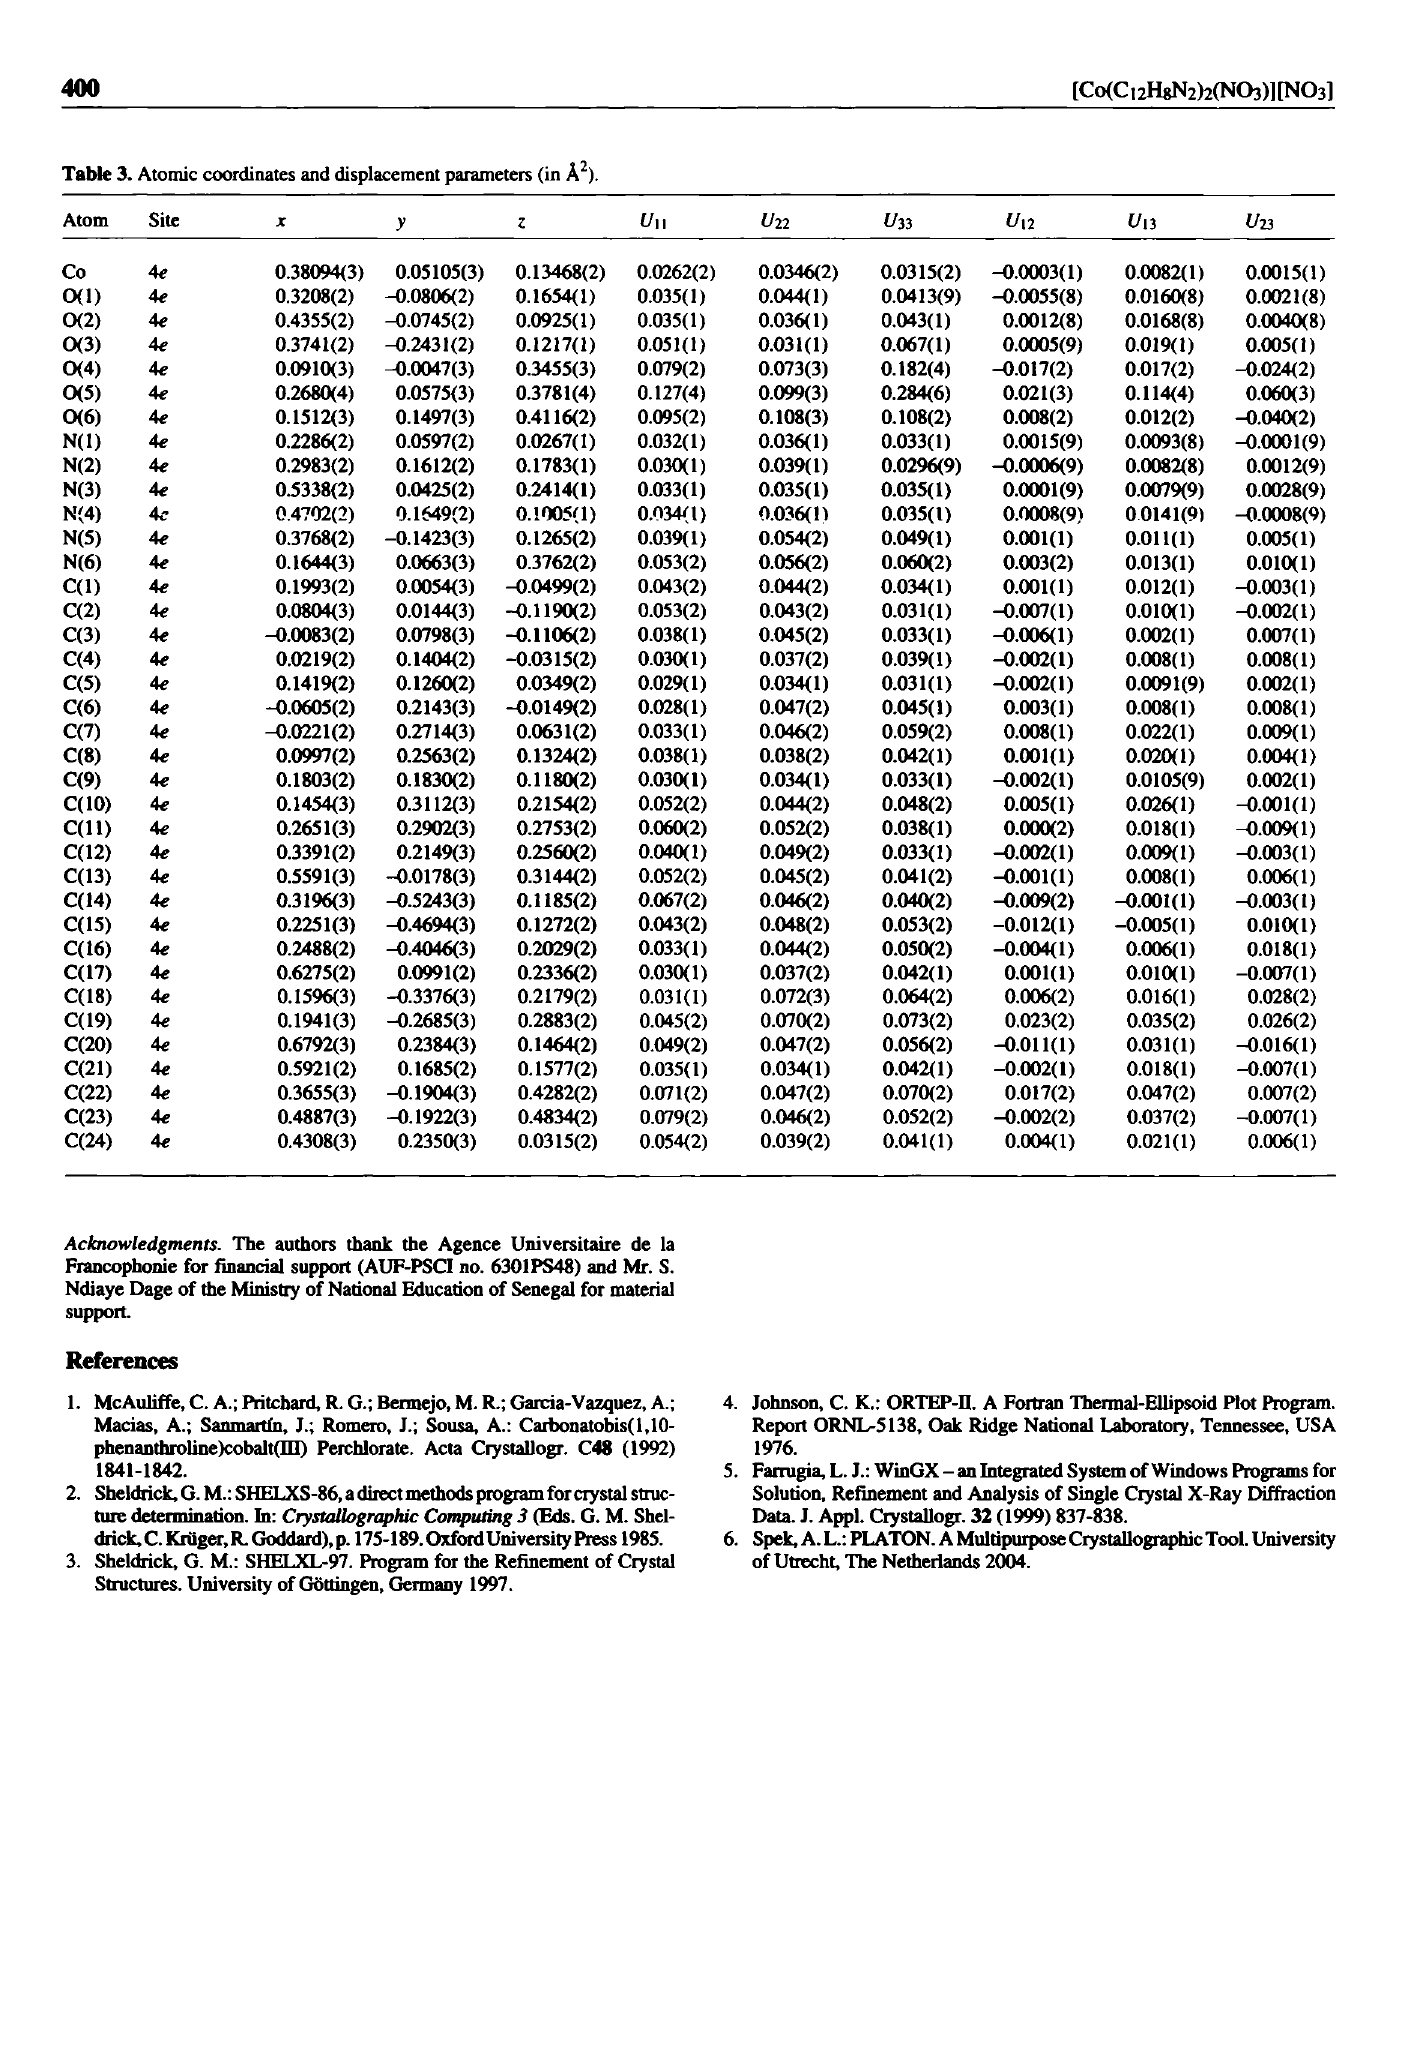
Table 3. Atomic coordinates and displacement parameters (in A 2